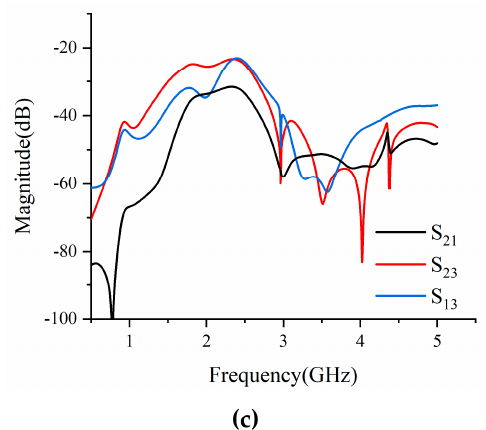
Figure 8. Summary of the simulated port isolations of the reconfigurable filtering antenna: ( a ) UWB state (D1 on, D2 and D3 off); ( b ) 2.4 GHz narrowband (D2 on, D1 and D3 off); and ( c ) 3.5 GHz narrowband (D3 on, D1 and D2 off).